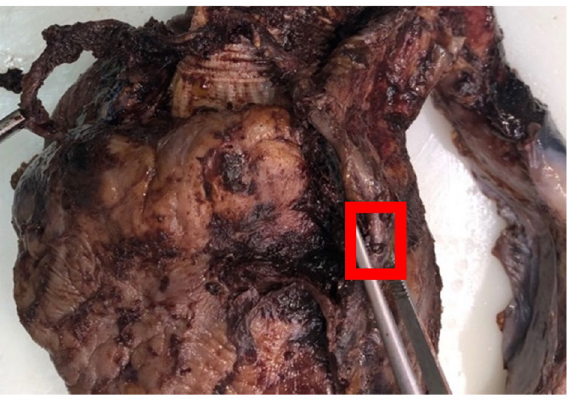
Figure 1. The left coronary graft site of pseudoaneurysm with wall rupture (red box). Pericardium appeared vastly infiltrated and full of clots. Pleural cavities contained massive quantities of blood:830 ccs on the right side and 230 ccs on the left one. Histological examination showed that the fissure of the SVG (Figure 2) occurred first in the deepest layer and spread to the more superficial layers. Specifically, at the rupture, the